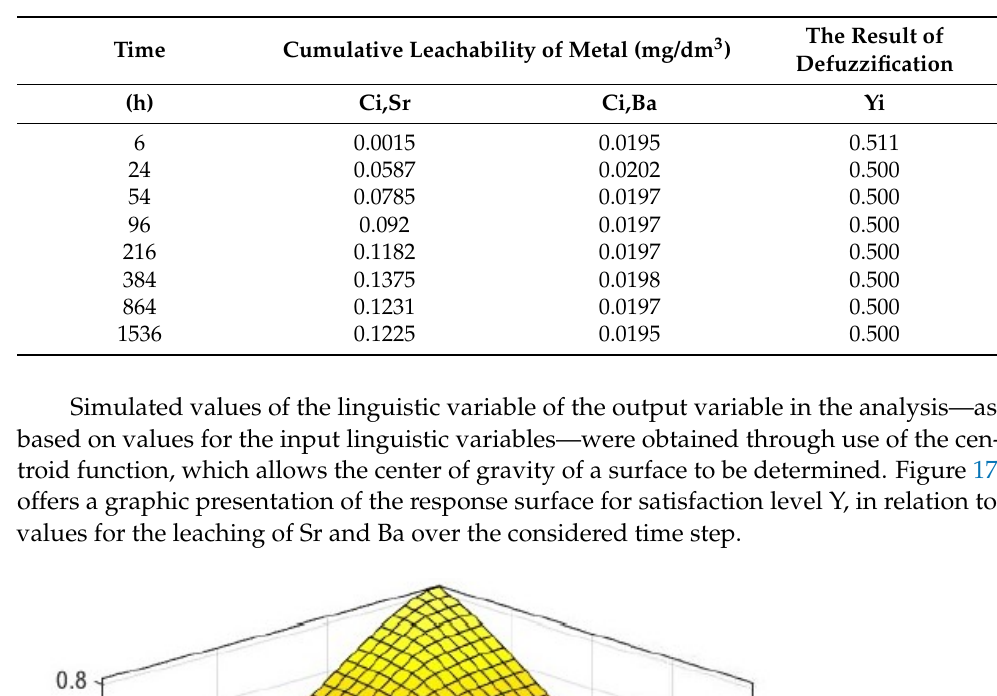
Table 7. Summary of the obtained values of the initial quantities for the empirically tested leachability of Sr and Ba from the rock.